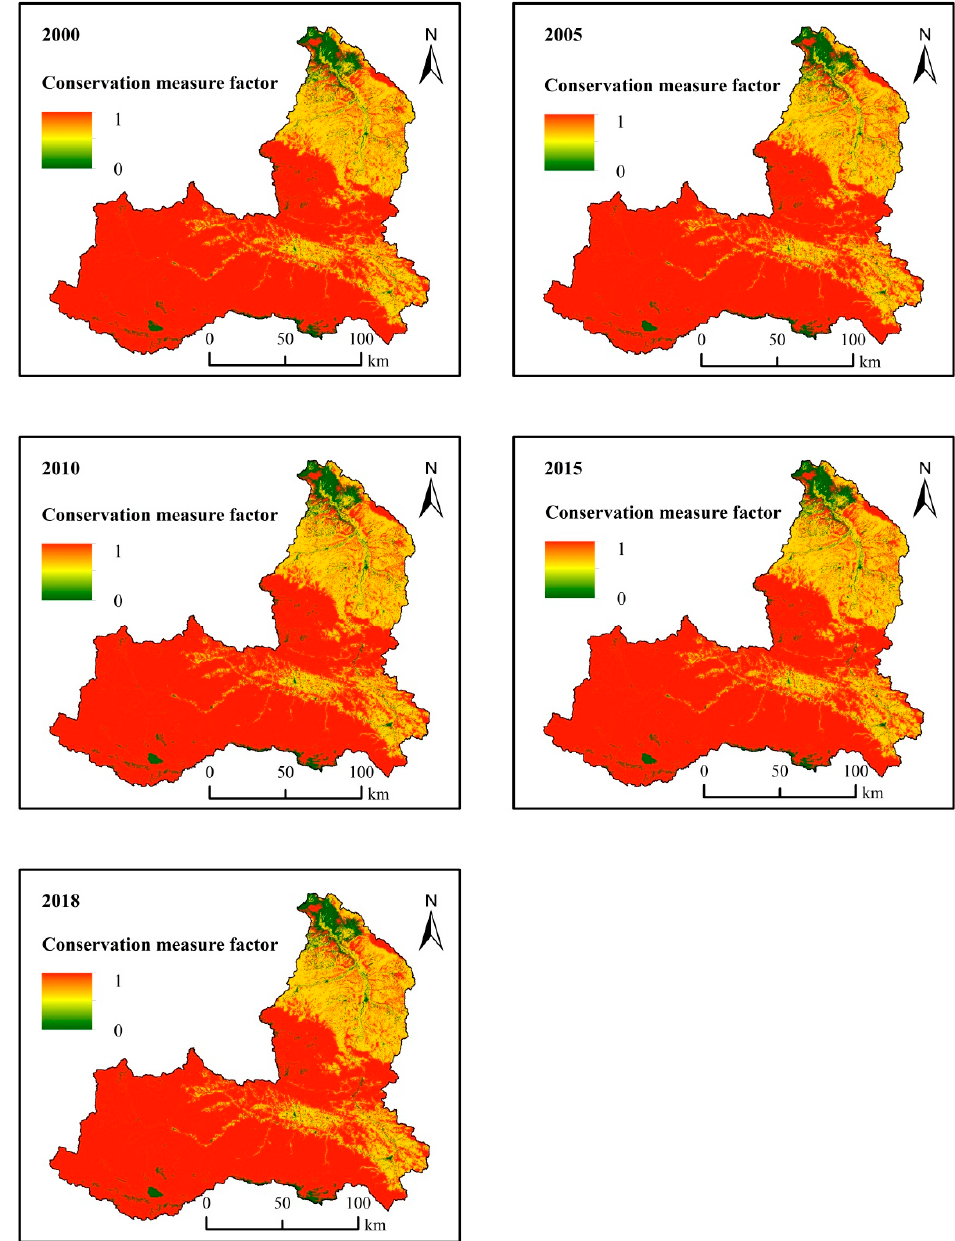
Figure 5. Spatial distribution of conservation measure factors in the Taohe River Basin in 2000, 2005, 2010, 2015 and 2018.